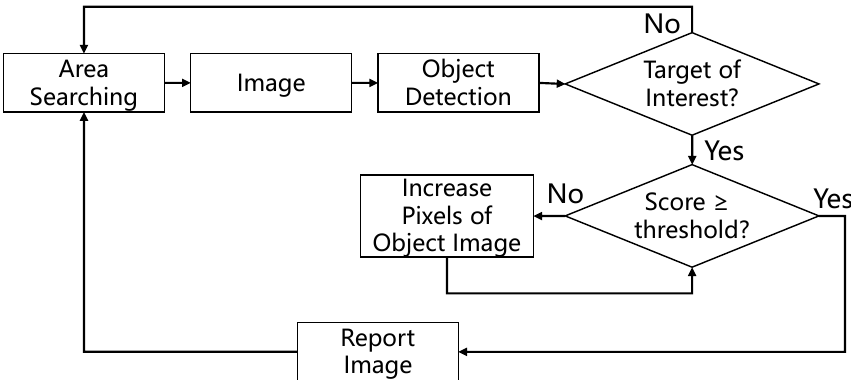
Figure 5. The workflow of the proposed intelligent object